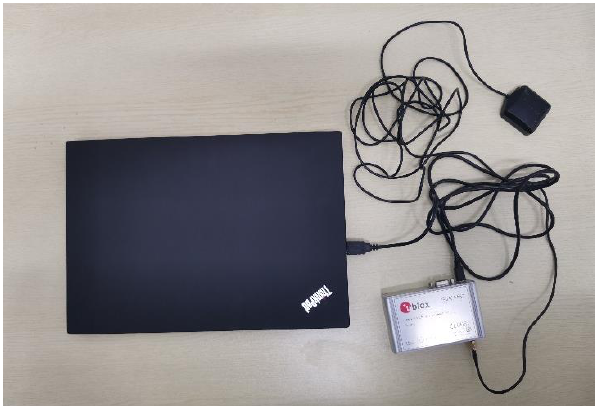
Figure 12. Observation equipment for the SPP experiment.